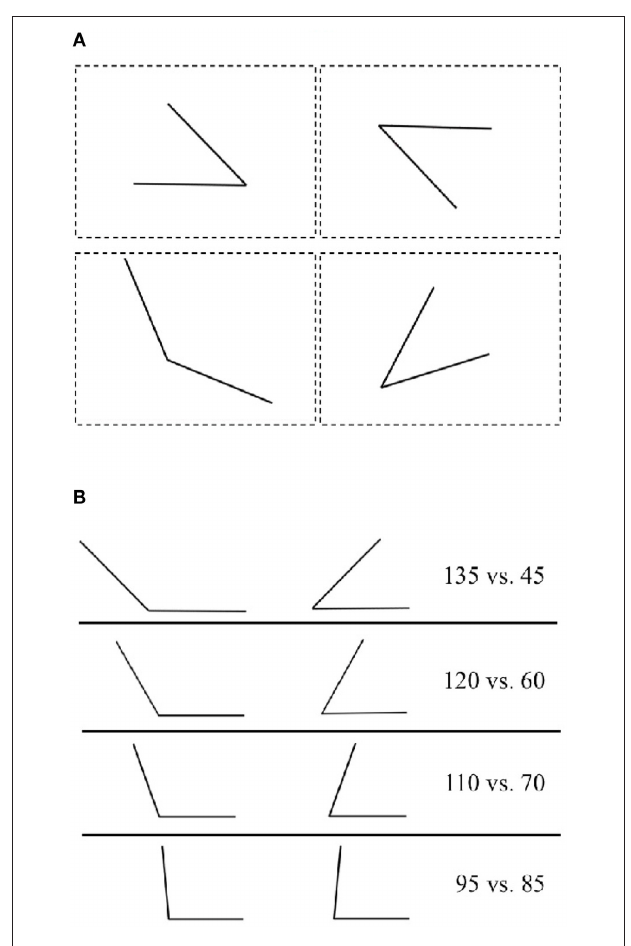
FIGURE 1 | (A) Illustration of the organization of the array of four small forms presented on each trial with AOI:s superimposed as dashed rectangles. (B) Illustration of the small forms used in each of the four